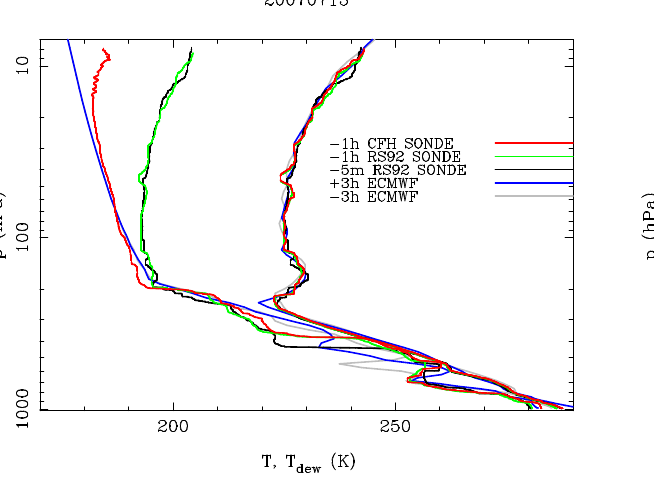
Fig. 5. Temperature (right) and water vapour profiles (left) for the CFH and RS92 sonde launched 1h before overpass time (red and green, respectively), the RS92 sonde launched 5min before IASI overpass (black) and the ECMWF analysis profile approximately 3h before and after satellite overpass (grey and blue, respectively). Note the big difference between the ECMWF analyses and the ra- diosondes moisture at 200hPa.